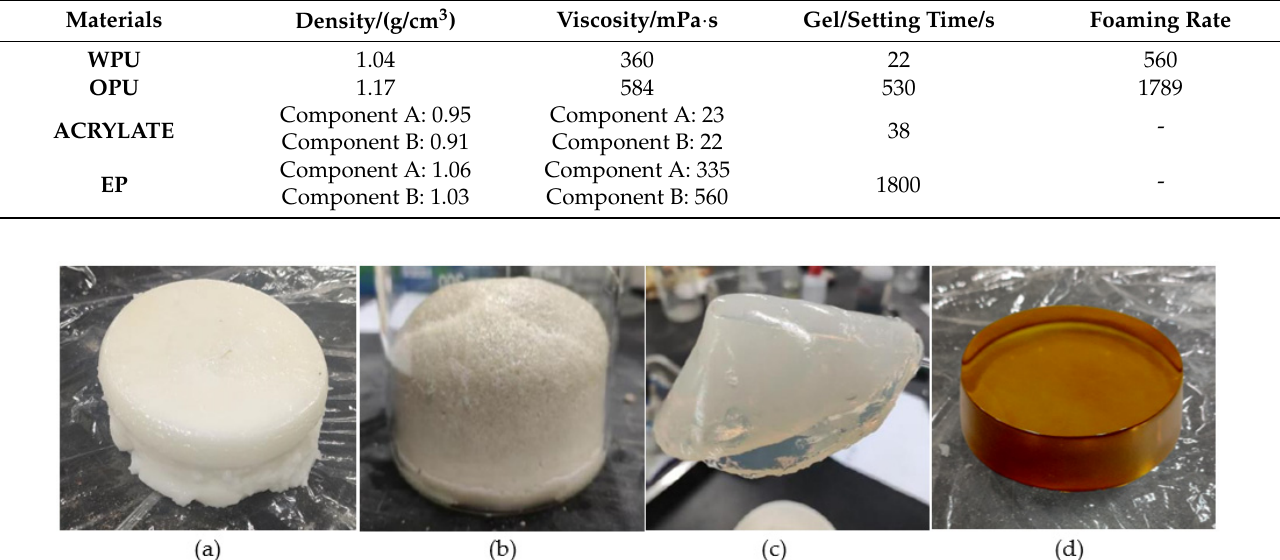
Figure 5. Chemical grouted sands destruction form: ( a ) EP grouted sands; ( b ) acrylate grouted sands. Among these four materials, WPU is a single ‐ component polymer slurry, which can react directly with water and has the fastest reaction speed. WPU grouted sands have high impermeability and can better reflect the time when the slurry diffuses in the sand. There ‐ fore, it is preferable to carry out sand diffusion tests with WPU. 3. Sand Diffusion Test 3.1. Experimental Design Options The study shows that the main components of the loose aquifer are coarse sand, me ‐ dium sand and fine sand. The main factors affecting the diffusion of sand are grouting pressure and the degree of loose sand. To explore which factors have the greatest influ ‐ ence on the diffusion of sand, it is necessary to design a comparative experiment. The orthogonal experiment can find the best experimental conditions and the characteristics of the greatest influence factor through the combination of fewer experiments. Therefore, a three ‐ level, three ‐ factor orthogonal trial was designed to carry out the study, and the experimental design is shown in Table 2.